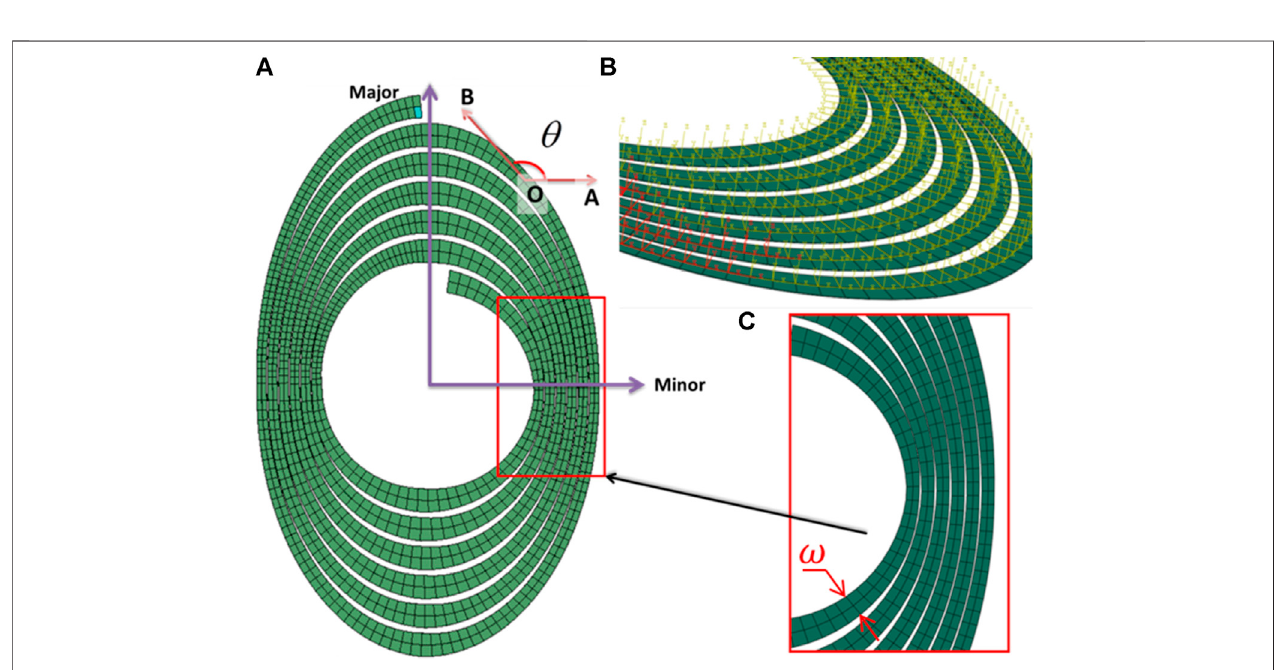
FIGURE3| MeshoftheTFPyarn: (A) 3Dsolidmeshgeneratedfollowingthepatternin Figure2C , (B) orthotropicmaterialwithlocal fi berorientationde fi nition,and (C) transitional yarn width and inter-yarn space.